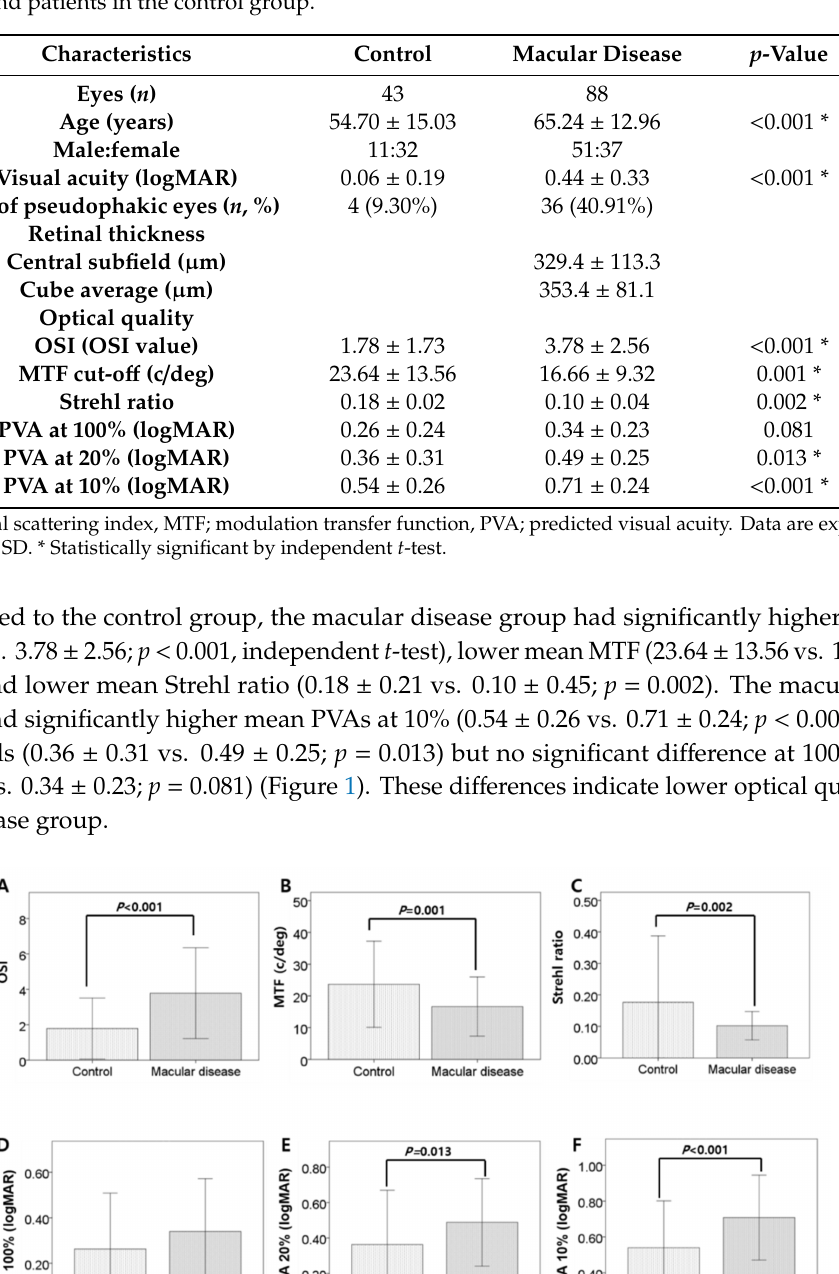
Table 1. Baseline characteristics and comparison of optical quality values in patients with macular disease and patients in the control group.